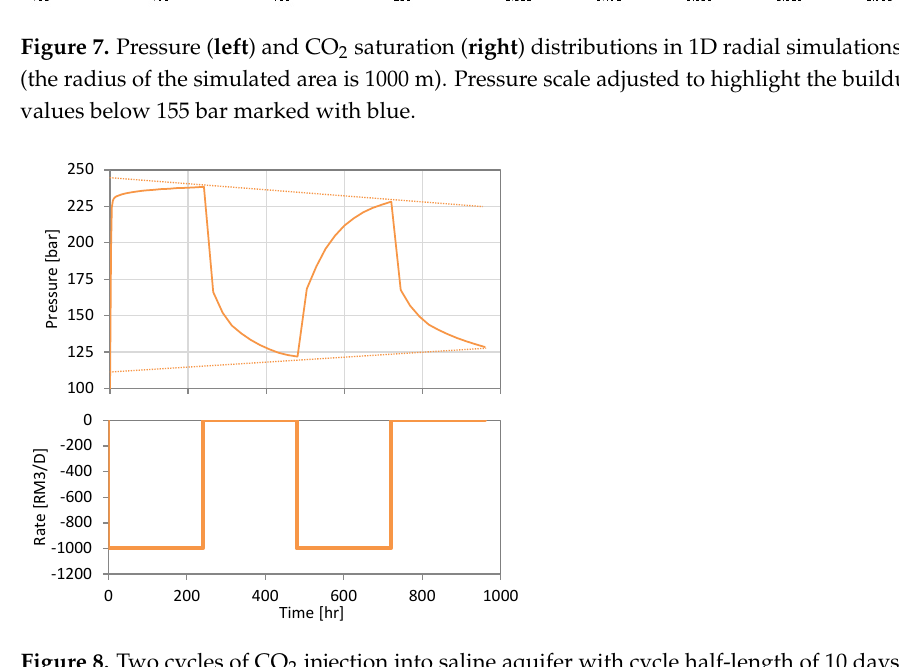
Figure 8. Two cycles of CO 2 injection into saline aquifer with cycle half-length of 10 days, 1D radial simulation in Eclipse.